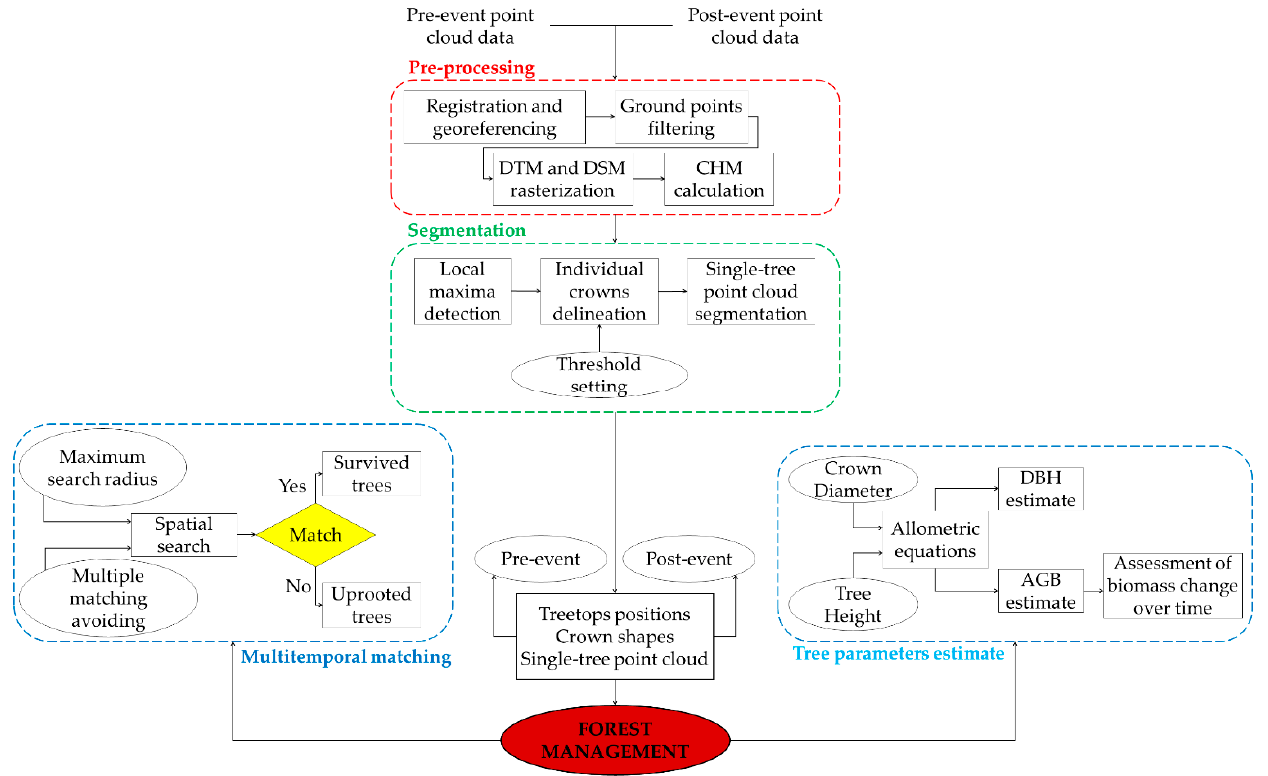
Figure 2. The workflow of the proposed method for the automatic detection of individual trees and the tree parameter estimation in multiple-time acquisitions.